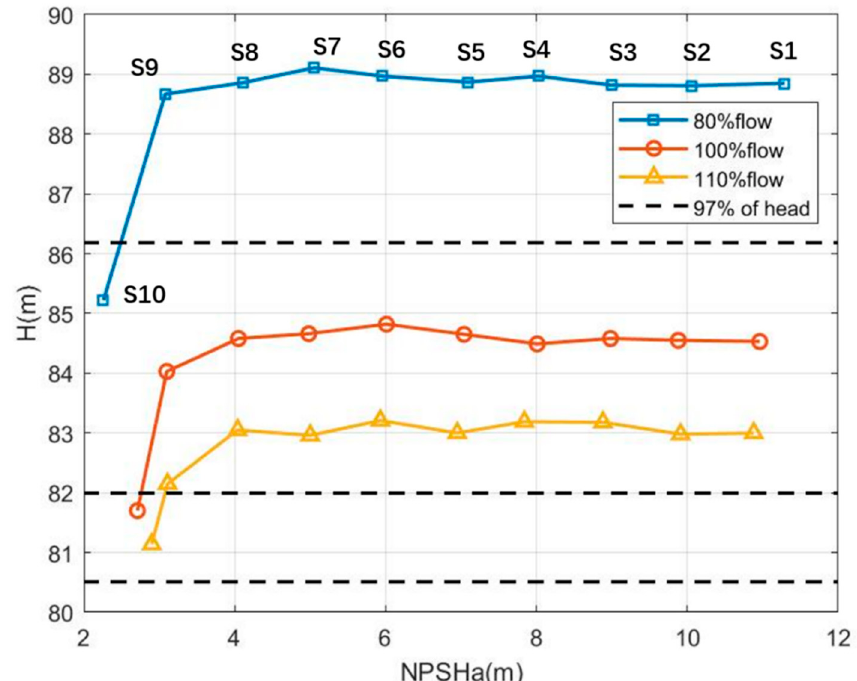
Figure 7. Net Positive Suction Head (NPSH)a-Head curve of the centrifugal water pump HZE80-50-250 (Delu pump company, Hangzhou, China). H denotes the Head in the vertical label. The sample point of each state is an average result of ten groups of experimental data. Each group of data contains 10 s records, including about 256,000 samplings.